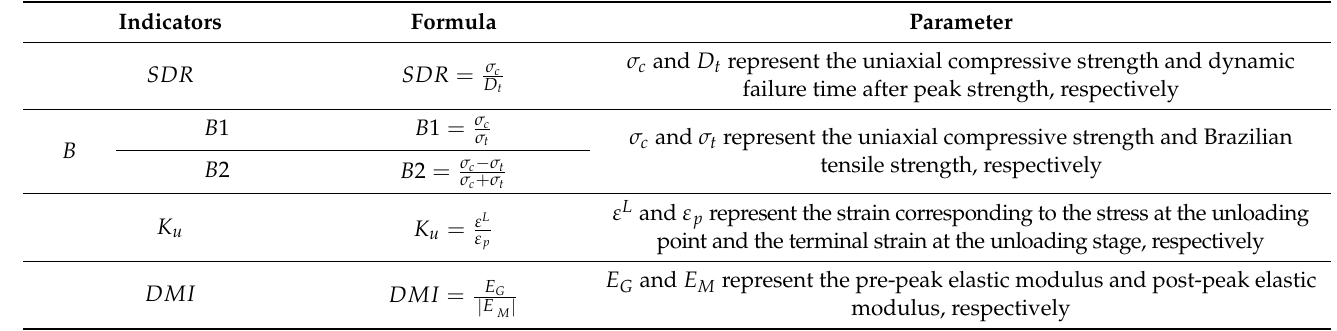
Table 1. Brittleness indicator and strength decrease rate for evaluation of rockburst tendency